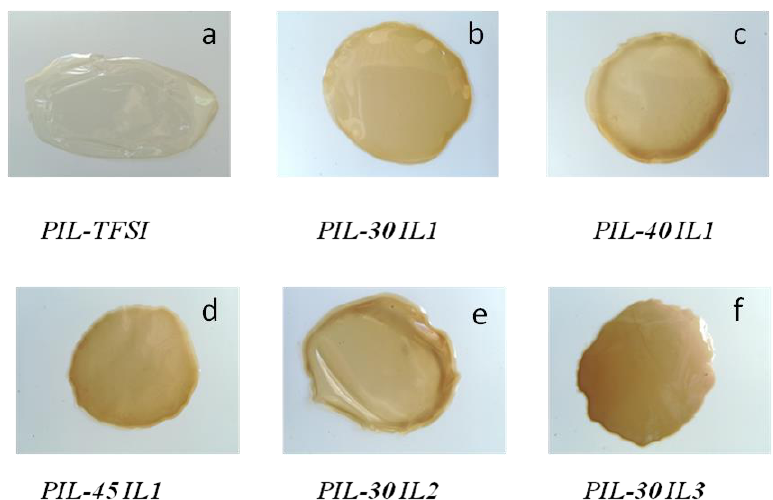
Figure 6. Images of the prepared ( a ) PIL-TFSI and PIL-IL composite membranes with ( b ) 30 wt % of IL1, ( c ) 40 wt % of IL1, ( d ) 45 wt % of IL1, ( e ) 30 wt % of IL2 and ( f ) 30 wt % of IL3.